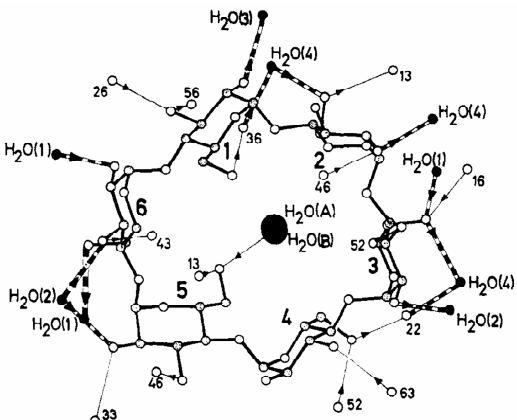
Figure 4. Structure of α -CD·(H 2 O) 6 and the hydrogen bonding network located inside the α -CD cavity. Reprinted with permission from Reference [132]. Copyright (1974) American Chemical Society.